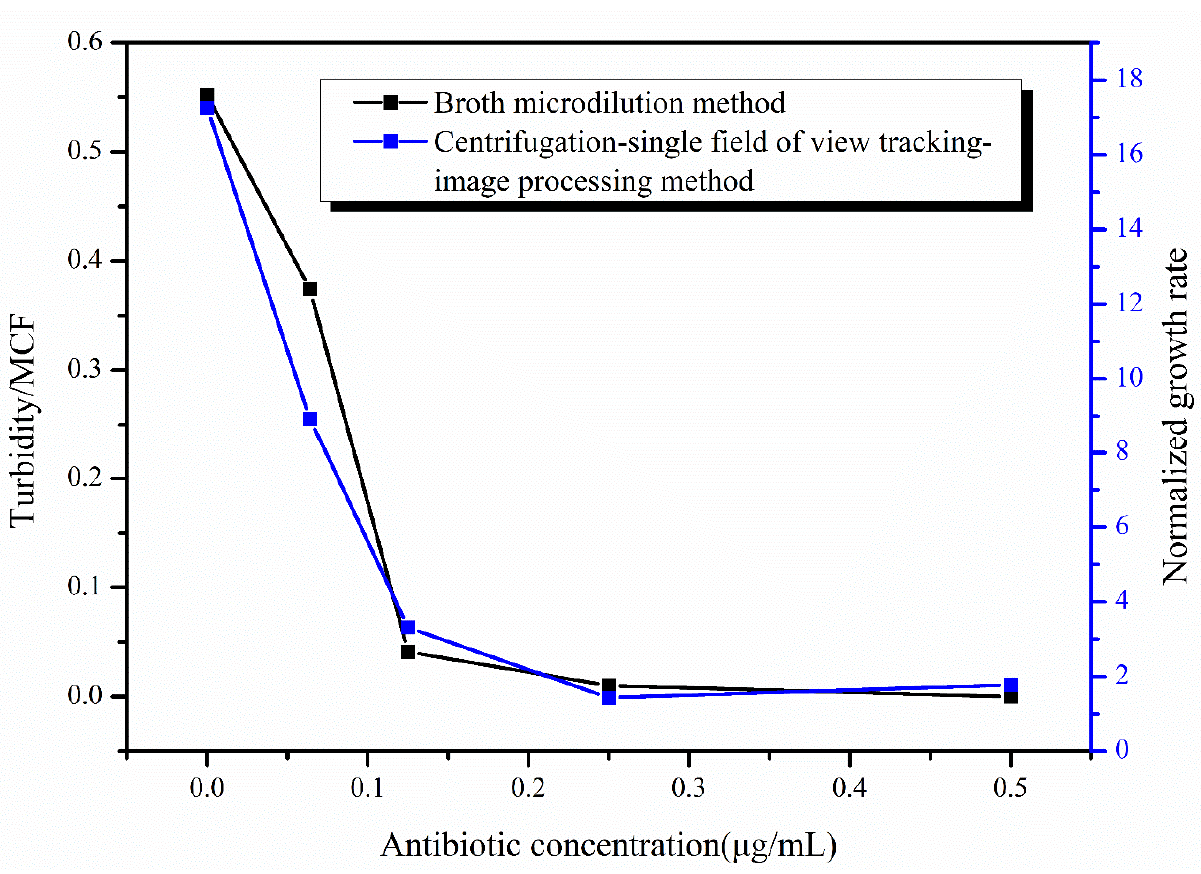
Figure 7. Results of the broth micro-dilution method (in black) and the centrifugation-single field of view tracking-image processing method (in